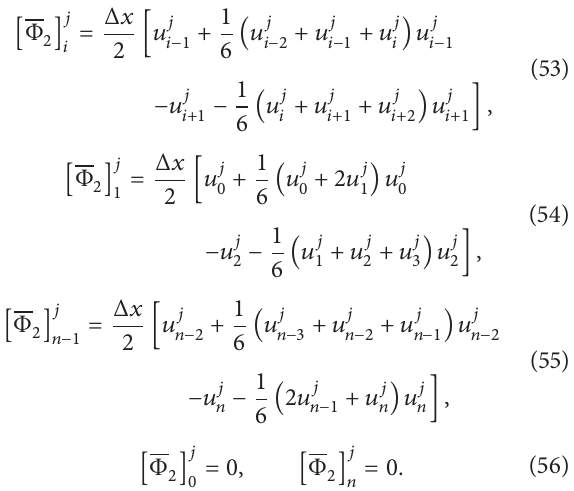
Figure 5: Figures showing the quantities log ( max Φ for the step lengths Δ𝑥 = 0.5, Δ𝑥 = 0.1 , and Δ𝑥 = 0.05 .